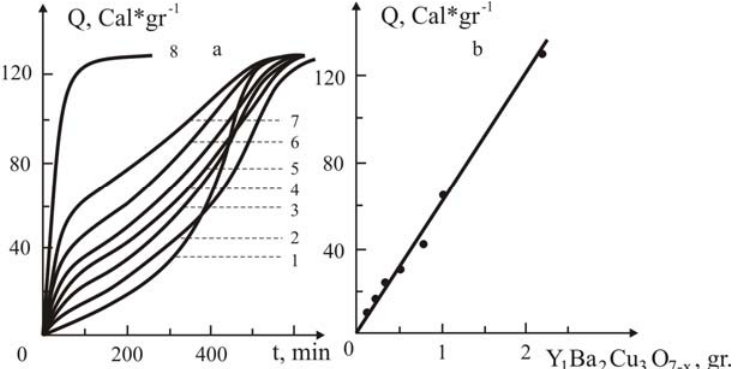
Figure 6. The influence of the added Y polymerization of MMA without initiator at 60 ° C (a) and the dependence of Q, vs. the added ceramic (b). Y 0.5 (5); 0.7 (6); 1 (7); 3.8 (8). Concentration of azobisisobutyronitrile is 3 ⋅ 10 -2 M´L -1 without ceramic